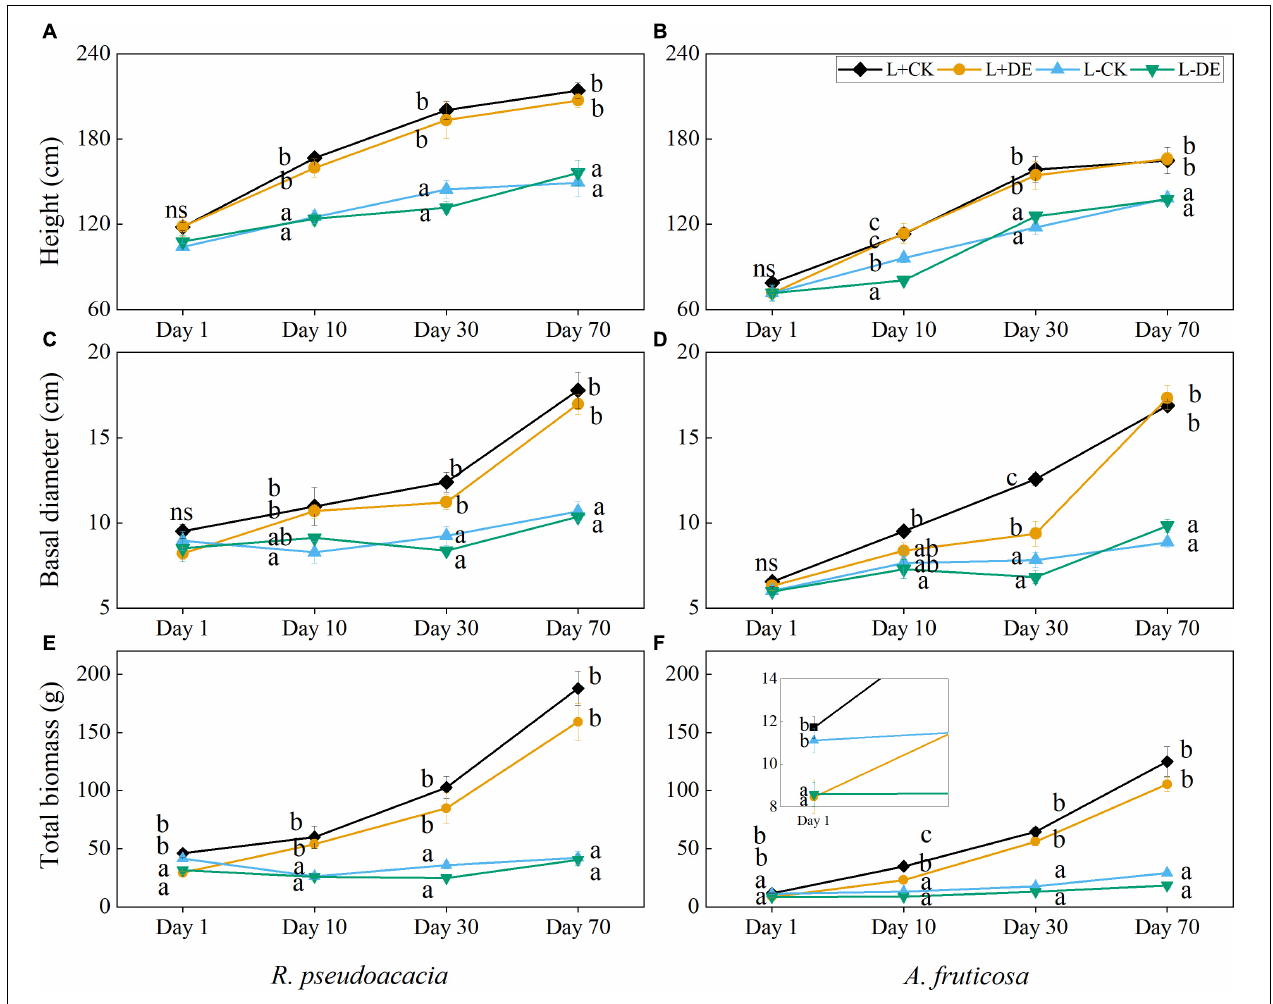
FIGURE 1 | Seedling height, basal diameter, and total biomass of R. pseudoacacia (A,C,E) and A. fruticosa (B,D,F) under different light and defoliation treatments. The values are shown as mean ± SE ( n = 4). Different letters indicate significant differences among different treatments in each sampling according to Duncan’s